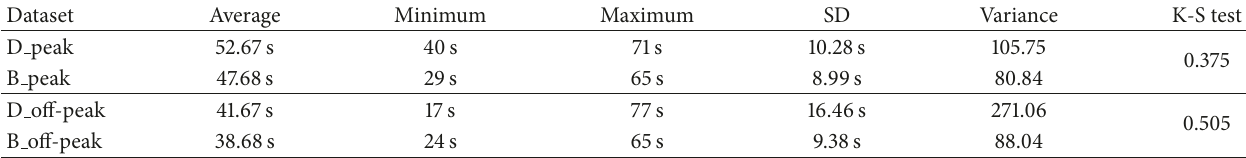
Table 4: Comparison between Dutch and Beijing datasets.